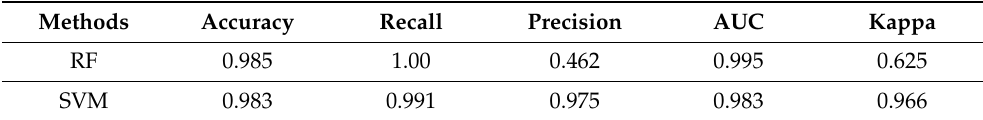
Table 6. External validation